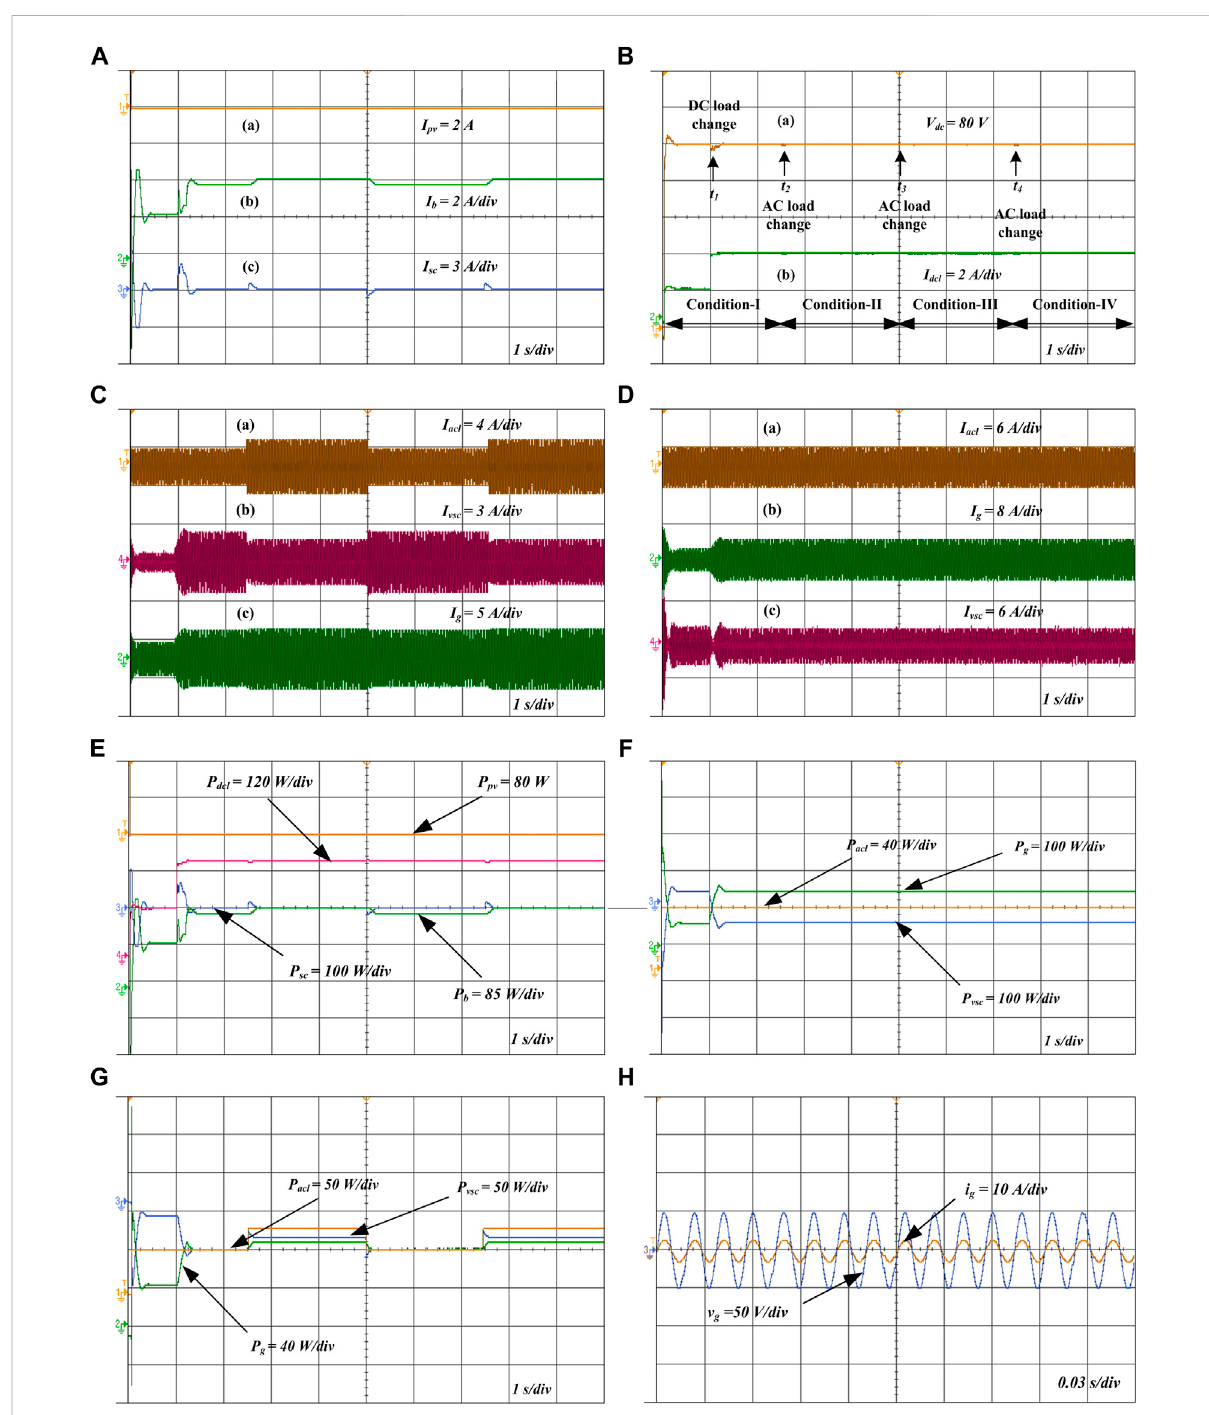
FIGURE 18 (A) HIL results: (a) PV, (b) BS, and (c) SC currents. (B) HIL results : (a) DC-link voltage, (b) D C load current. (C) HIL results: (a) AC load, (b) VSC, and (c) grid currents. (D) HIL results: (a) constant AC load, (b) grid, and (c) VSC currents. (E) HIL power results for PV, BS, SC, and DC load under DPM operation. (F) HIL power results for VSC, constant AC load and grid. (G) HIL power results for VSC, AC load and grid. (H) HIL results: grid current and grid